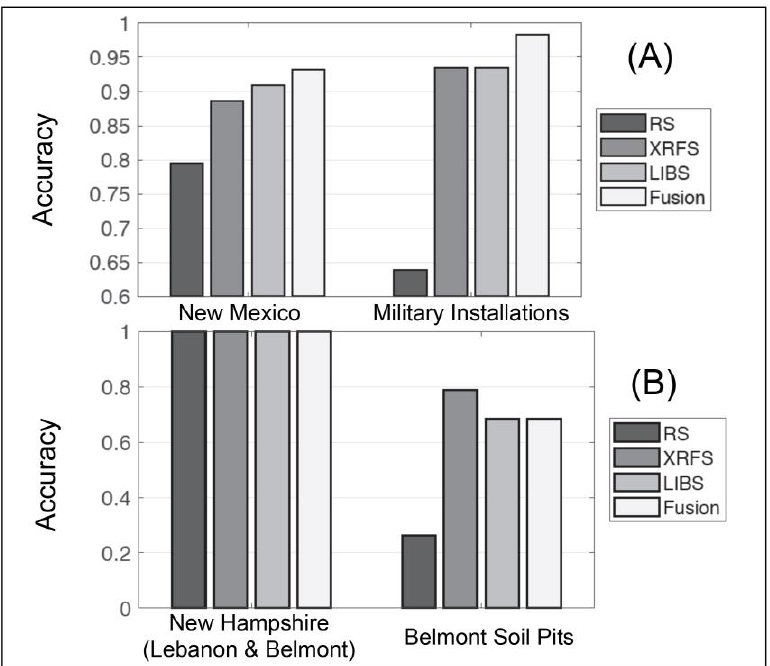
Figure 7. Classification accuracy for the individual XRFS, RS, and LIBS analyzers and for three-instrument data fusion for ( A ) the New Mexico (left) and military installation soils (right) and ( B ) the New Hampshire Lebanon and Belmont and Lebanon locations (left) and the three Belmont location soil pits (right) described in Table 1.